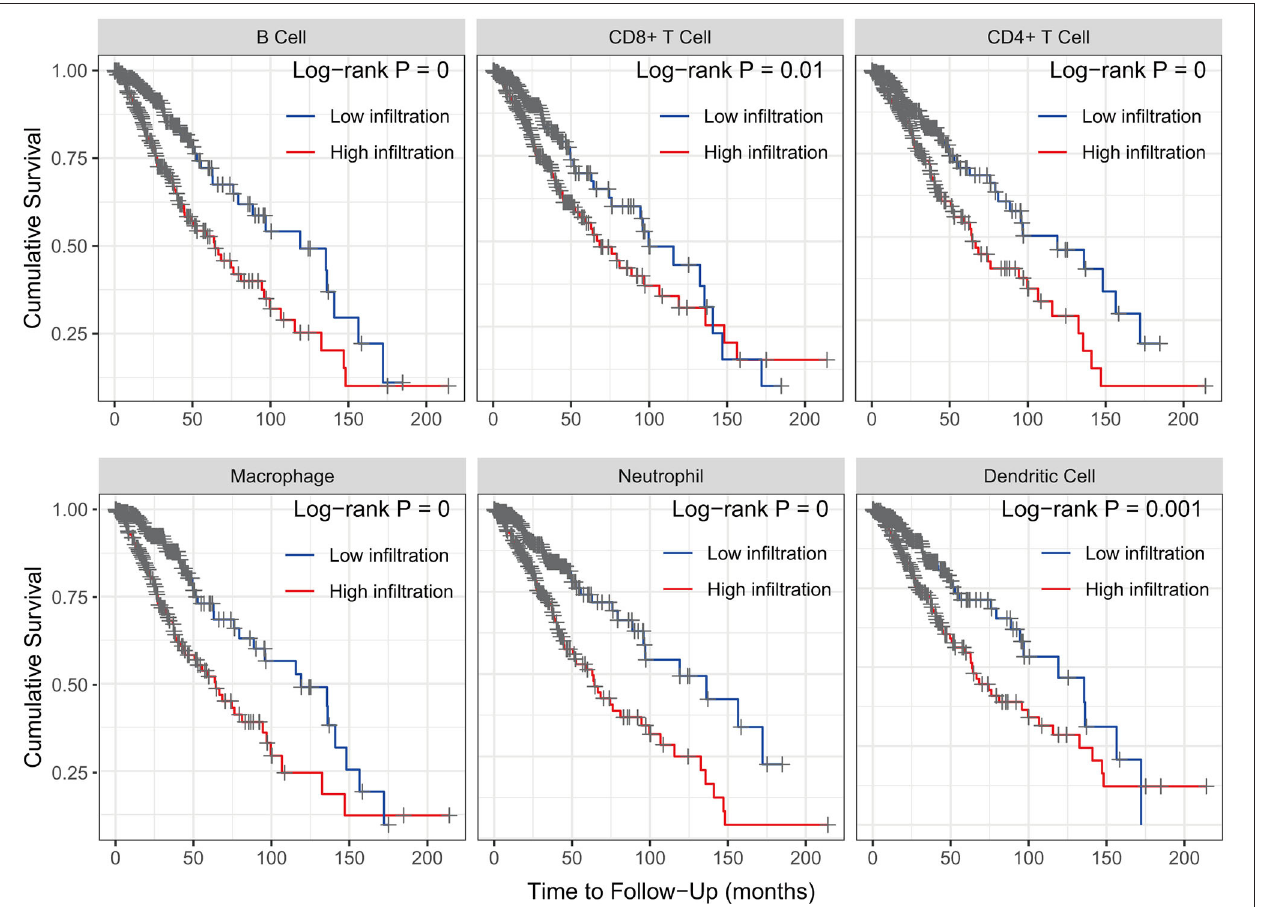
FIGURE 5 | Kaplan–Meier analysis reveals that lower immune cell (B cells, CD4 + T cells, CD8 + T cells, neutrophils, macrophages, and dendritic cells) infiltration levels are correlated with poor survival outcomes in LGGs ( p < 0.05).